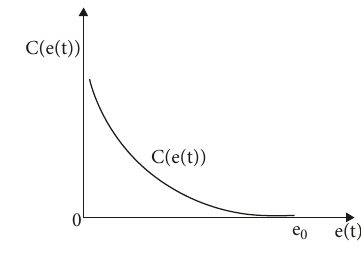
Figure 5: The function graphic of 𝐶(𝑒(𝑡))